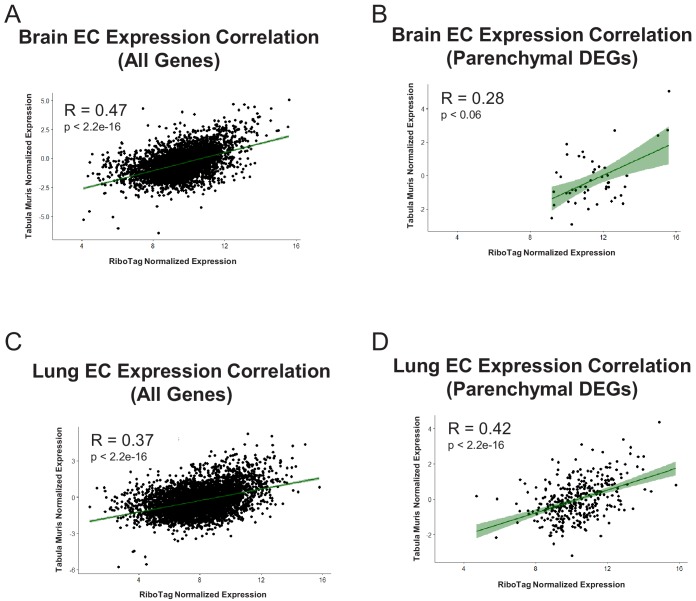
Endothelial gene expression correlation analysis across three distinct datasets (RiboTag Endothelial Translatome, Betsholtz single-cell transcriptomics, Tabula Muris single-cell transcriptomics).Spearman correlation scatter plots of average gene expression in RiboTag bulk RNA-Seq and Betsholtz scRNA-Seq were generated for (A) all genes detected in brain ECs and (B) parenchymal (non-endothelial) genes detected in brain ECs. (C) Average expression level of representative brain EC parenchymal genes. Spearman correlation scatter plots of average gene expression in RiboTag bulk RNA-Seq and Betsholtz scRNA-Seq were generated for (D) all genes detected in lung ECs and (E) parenchymal (non-endothelial) genes detected in lung ECs (F) Average expression level of representative lung EC parenchymal genes. Spearman correlation scatter plots of average gene expression in RiboTag bulk RNA-Seq and Tabula Muris scRNA-Seq were generated for (D) all genes detected in heart ECs and (E) parenchymal (non-endothelial) genes detected in heart ECs (F) Average expression level of representative heart EC parenchymal genes.